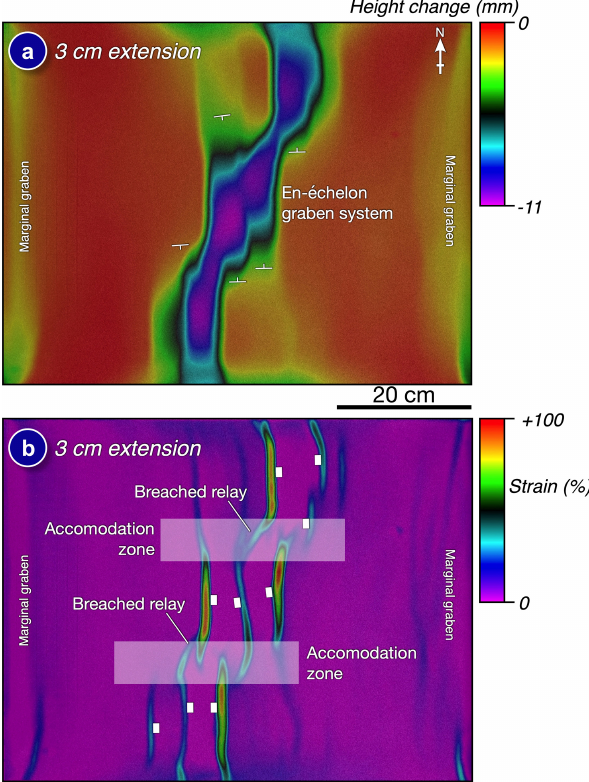
Figure 3. (a) Height-change map of Model 1 after pre-salt exten- sion. Three en-échelon graben in model center are separated by accommodation zones with relays. Marginal graben formed at the model periphery. (b) Strain map of Model 1 during pre-salt ex- tension. Accommodation zones consist of interlocking extensional faults. Note that some relays are breached. See text for further de-